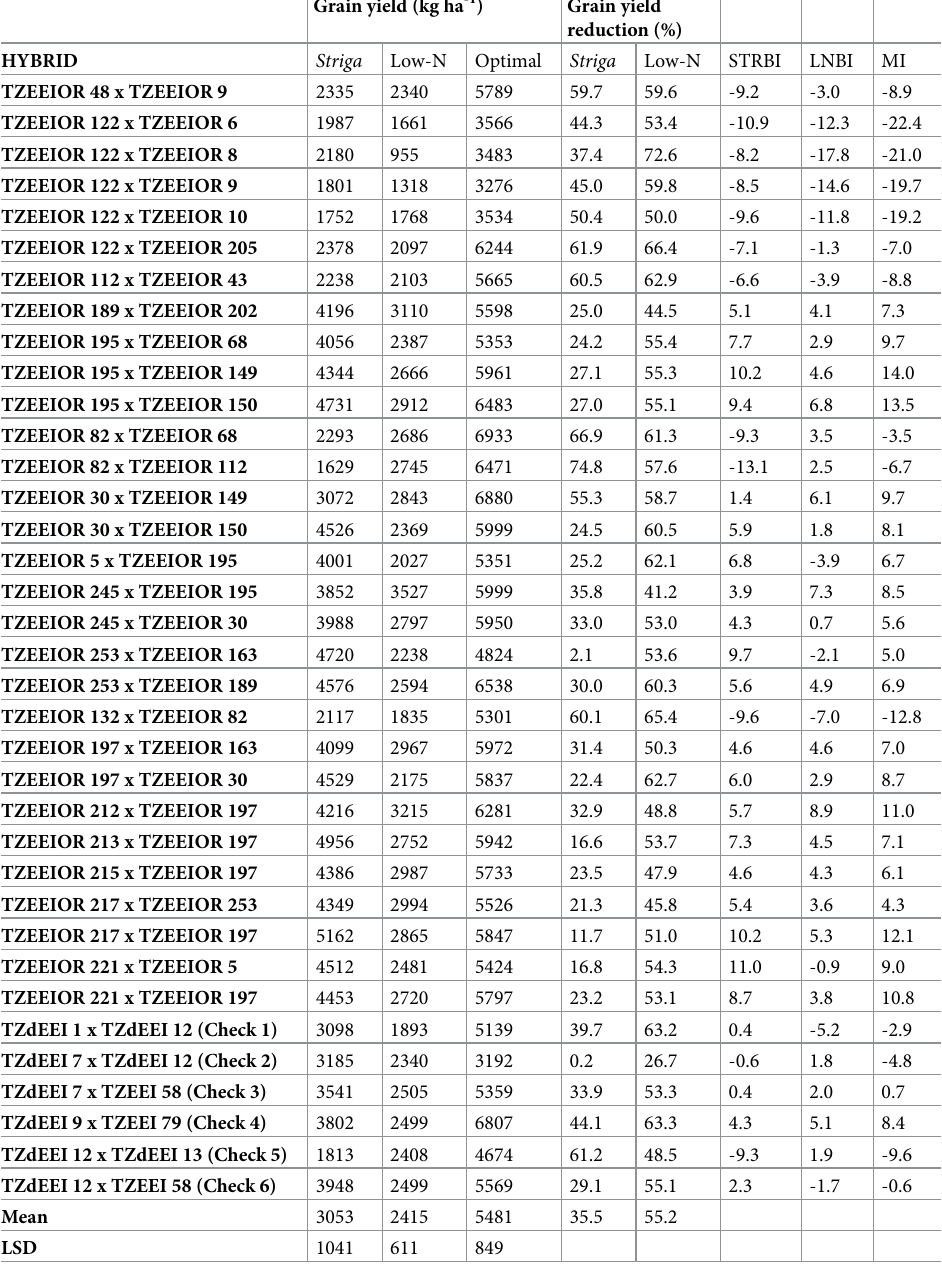
Table 8. Grain yield of selected PVA maize hybrids across Striga , low-N and optimal conditions.